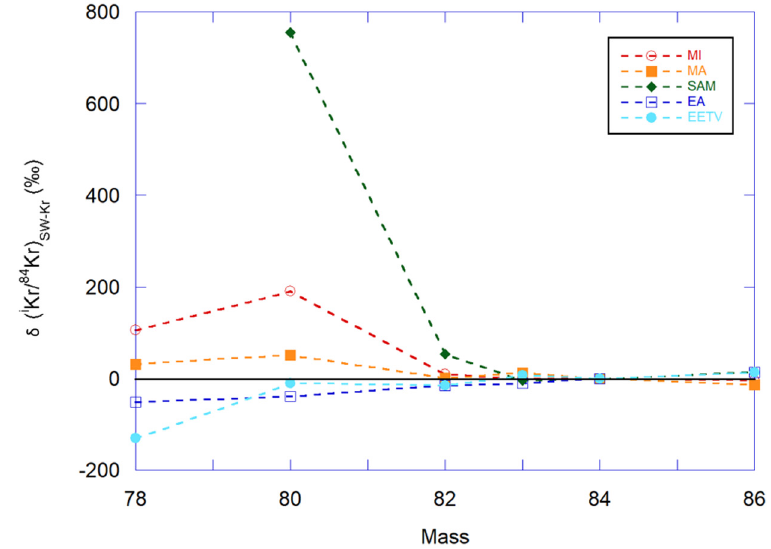
Figure 7. Kr isotopic composition in Earth and Mars atmospheres (EA and MA, respectively), Mars Interior (MI) and Curiosity (SAM) data ([53], and references therein). Isotopic compositions are given using the delta notation, normalized to 84 Kr and to solar wind krypton (SW-Kr, black line), following the formula: δ i Kr SW-Kr = 1000 × (cid:3124)(cid:3120)(cid:3260)(cid:3293) (cid:3278)(cid:3290)(cid:3288)(cid:3291)(cid:3290)(cid:3289)(cid:3280)(cid:3289)(cid:3295) (cid:3398) 1(cid:4685) . Error bars are omitted for the clarity of the data. Adapted and modified from the work in [53].